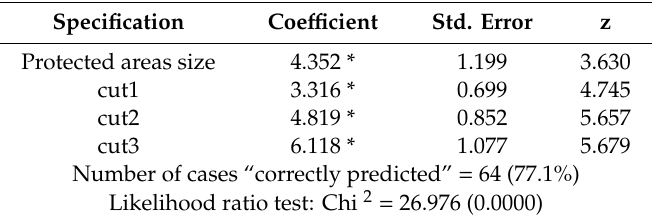
Table A1. Selected logit model